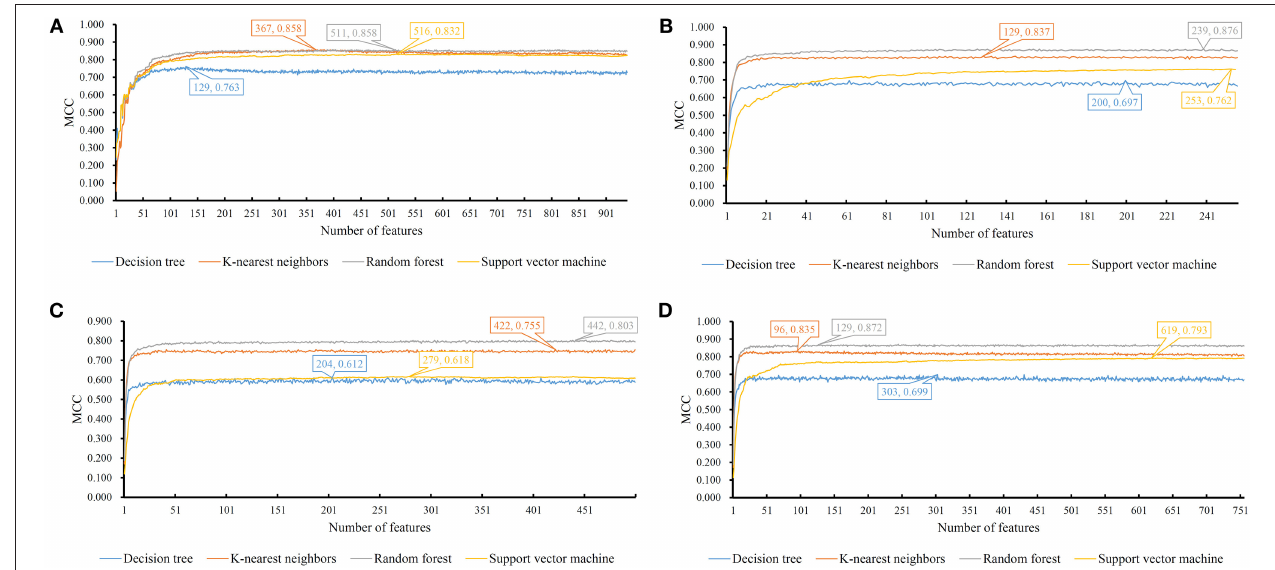
FIGURE 3 | MCC changes with the number of features for IFS with different classification algorithms. (A) one-hot encoded representation derived from KEGG/GO terms; (B) functional embeddings from KEGG/GO terms; (C) network embeddings from a protein-protein network; (D) the combined functional and network embeddings.